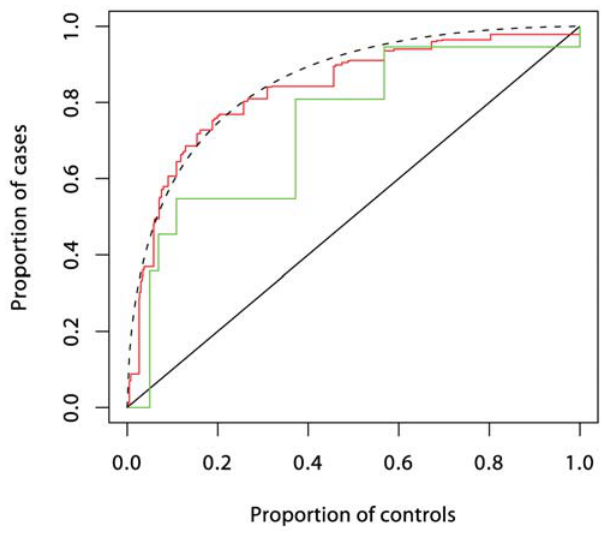
Figure 3. ROC curves prediction from loci in the MHC region. Prediction using six single nucleotide polymorphisms (SNPs) is shown in red, while prediction using HLA-DRB1 is shown in green. These curves (and those in Figures 4 and 5) were obtained by fitting logistic regression models as described in Text S1 and calculating the proportions of cases and controls with prediction scores exceeding each possible value. The dashed curve corresponds to the theoretical curve for the polygenic multiplicative model with l s =3.13.